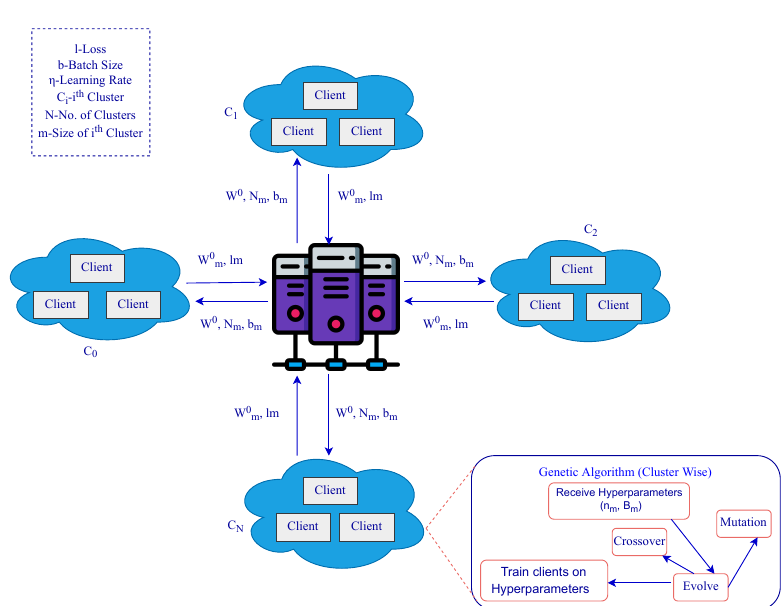
Figure 1. Genetic CFL